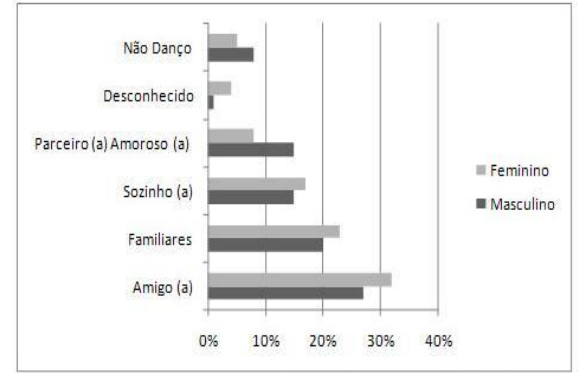
Figura 1. Questão sobre se os participantes costumam dançar nas festas, com possibilidade de assinalar uma única alternativa.